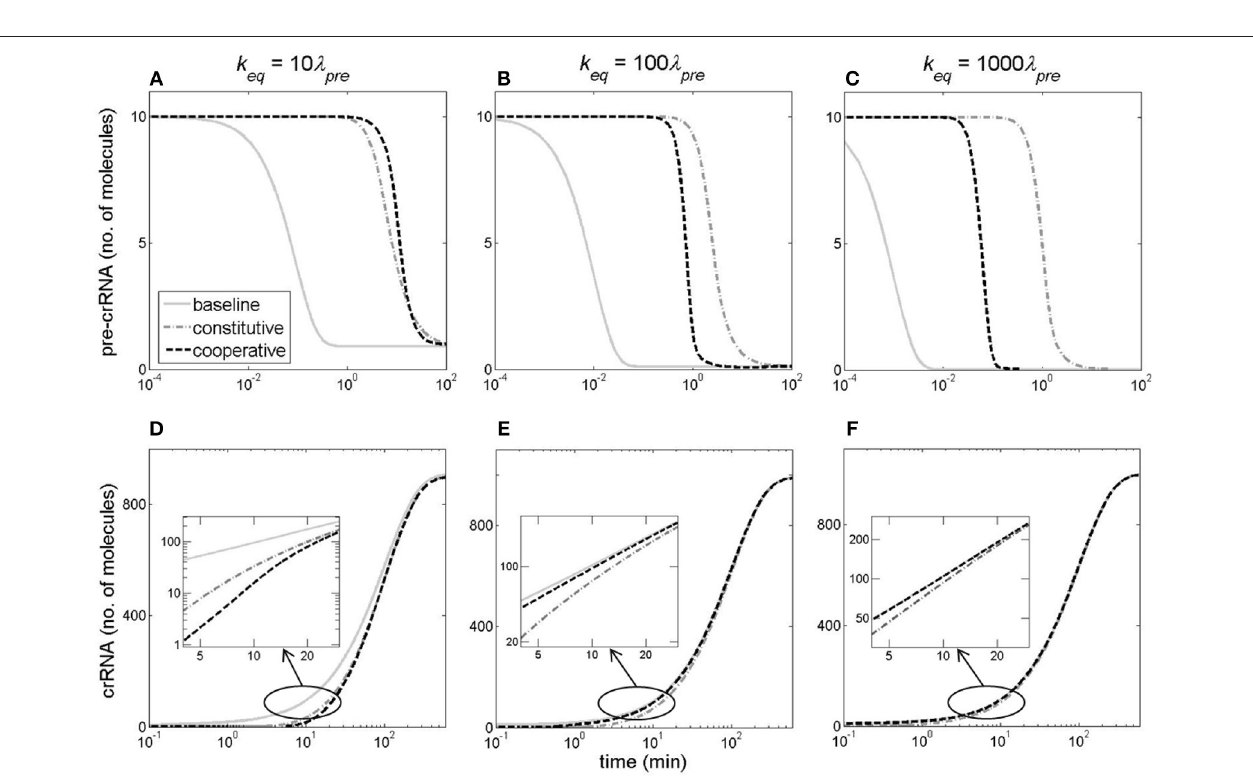
FIGURE 7 | Kinetics of pre-crRNA and crRNA generation. The columns correspond to k eq values of 10 λ pre (A,D) , 100 λ pre (B,E) , and 1,000 λ pre (C,F) , which are reached through the baseline model (the gray solid curve), the constitutive model (the gray dash-dotted curve) or cooperative model (the black dashed curve). The upper (A–C) and the lower (D–F) rows correspond, respectively, to pre-crRNA and crRNA kinetics. CRISPR array promoter transcription activity is kept constant at 10 1/min.